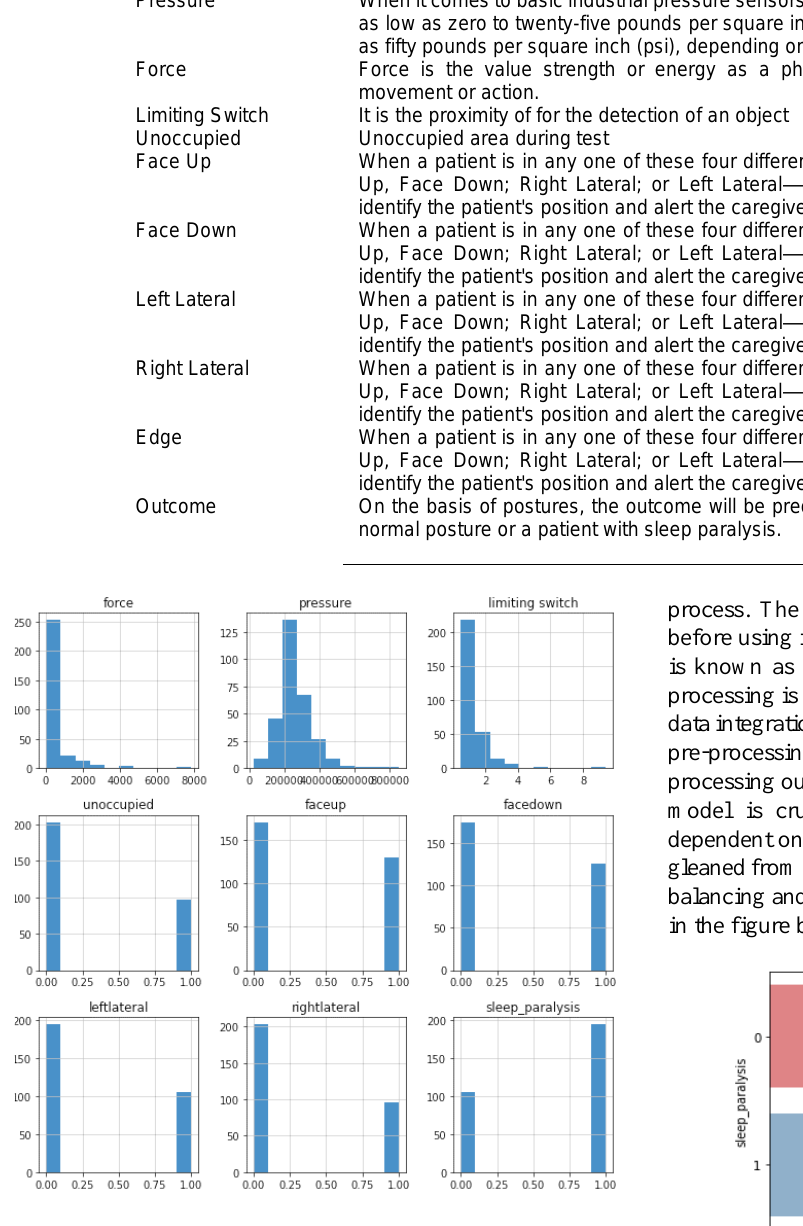
Figure 9. Data Attributes Visualization